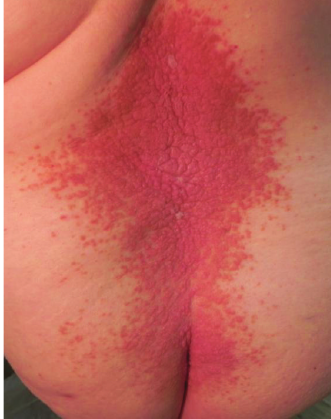
Figure 6: Keratotic papules are present on lower back.